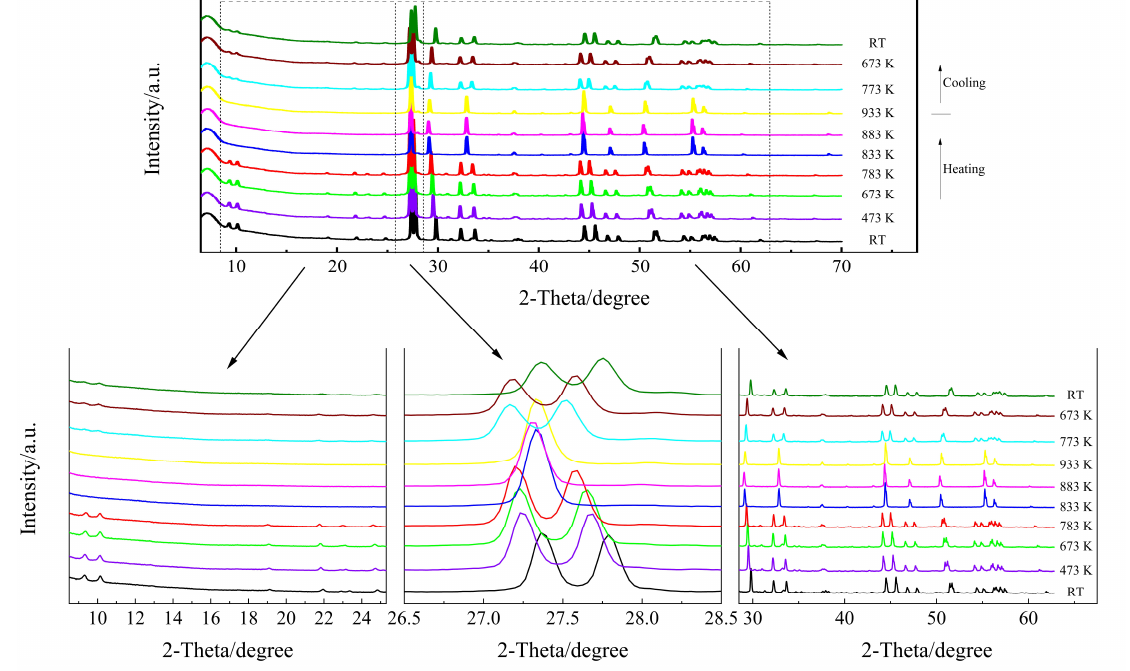
Figure 1. High-temperature XRD patterns of KBi(MoO 4 ) 2 , where RT stands for room